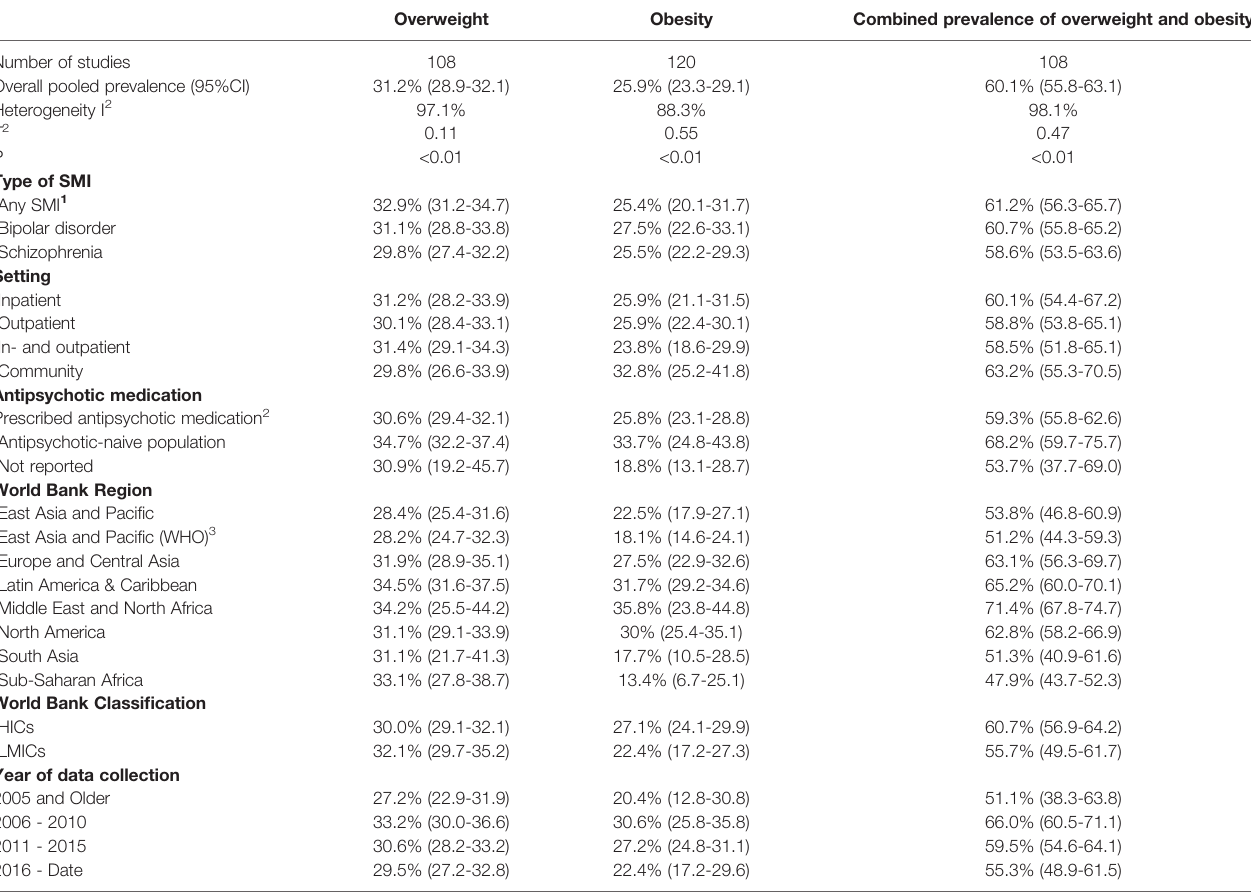
TABLE 2 | Pooledprevalence ofoverweightobesityandcombinedoverweightandobesityaccordingtoSMI, geographicalregion,WorldBankclassi fi cationandyear ofpublication. Overweight